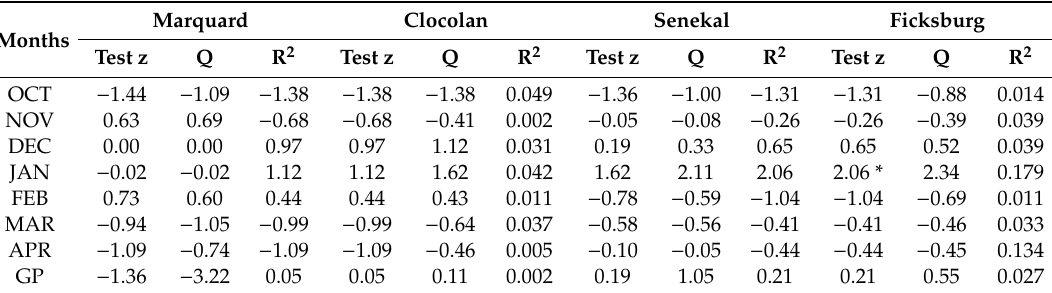
Table 7. Monthly rainfall (mm) and its annual trends during the growing period from 1985–2016 for the Setsoto municipality. MK Test Z denotes Mann Kendall trend analysis test, and Q denotes ‘the Sen’s slope